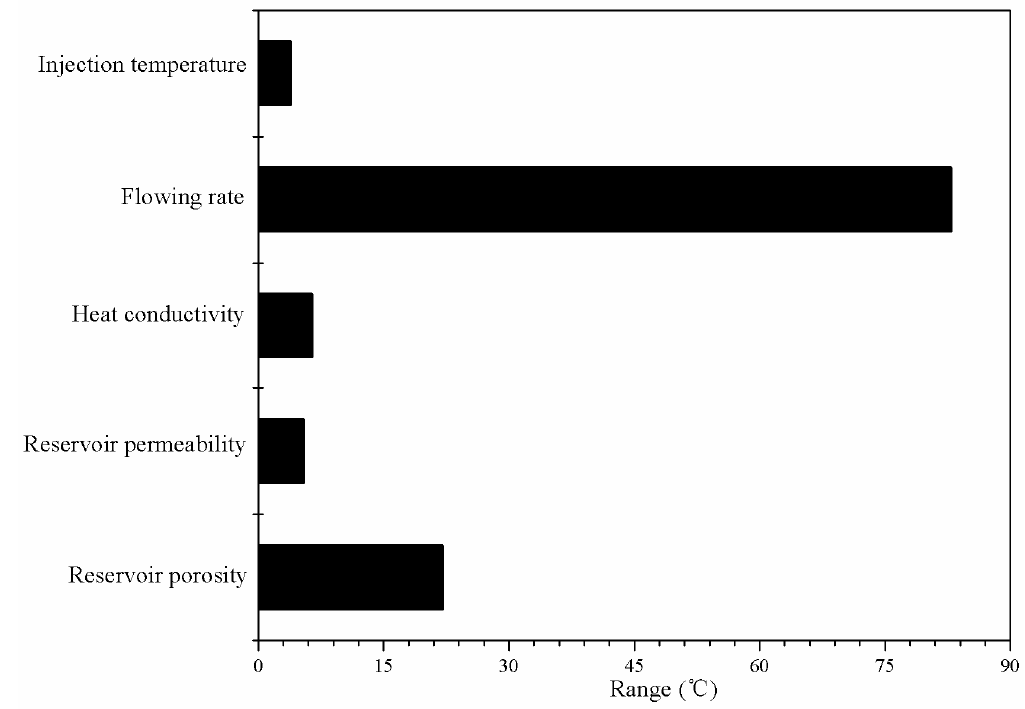
Figure 4. Ranking of the five conditions of the influential effects on the production temperature.